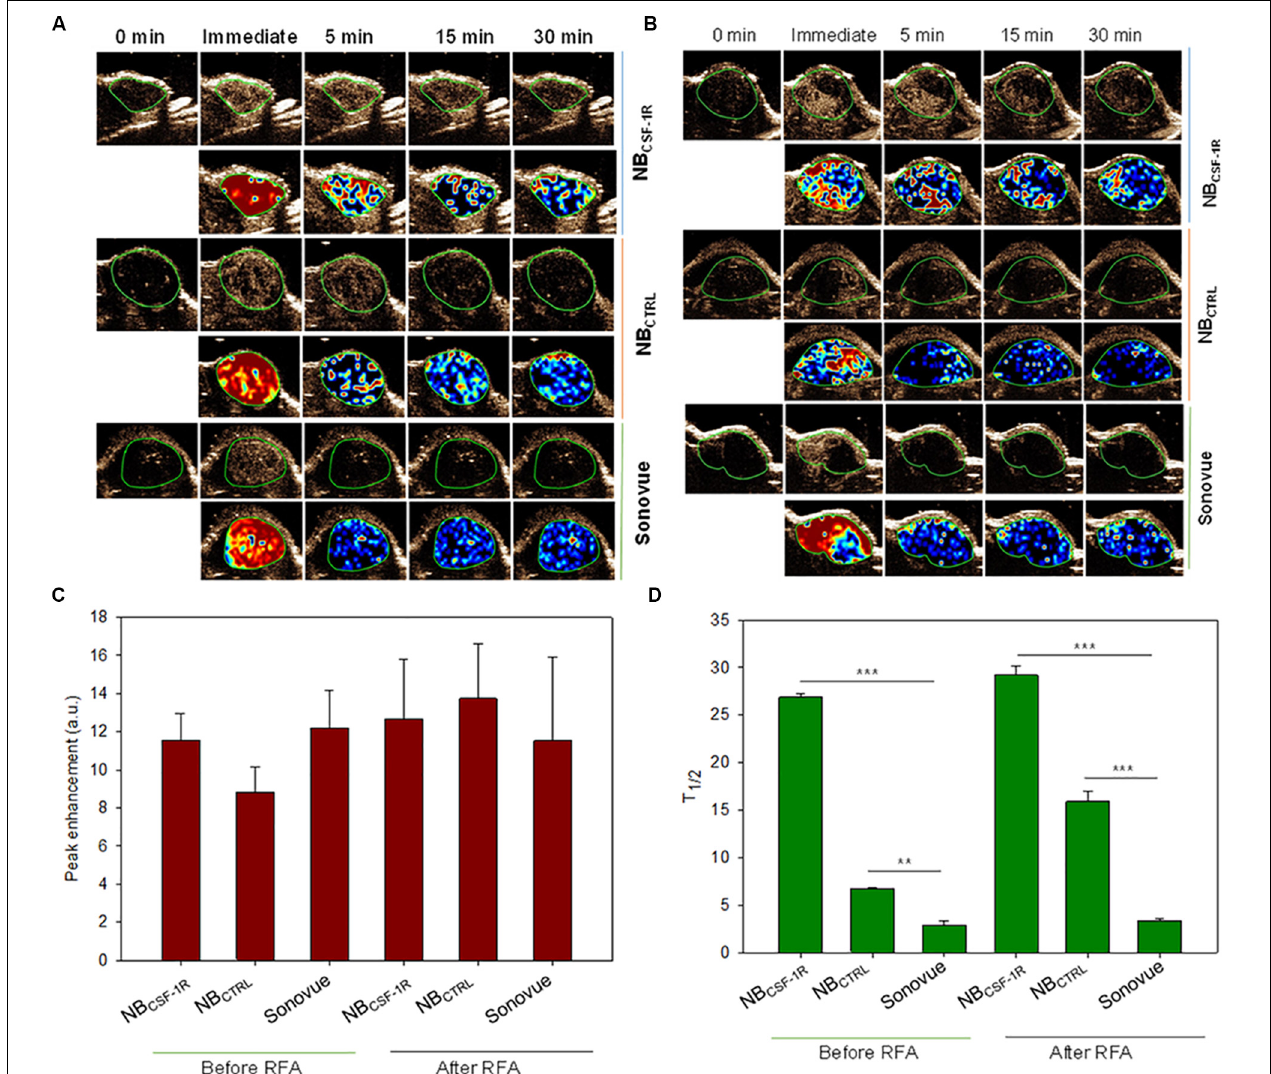
FIGURE 7 | (A) In vivo tumor imaging, images were taken at the indicated time points (0, immediate, 5, 15, and 30 min) after NB CSF − 1R , NB CTRL , and Sonovue R (cid:13) were injected into tail vein of the transplanted tumors. (B) In vivo tumor imaging, images were taken at the indicated time points (0, immediate, 5, 15, and 30 min) after NB CSF − 1R , NB CTRL , and Sonovue R (cid:13) were injected into tail vein of insufficient radiofrequency ablation (IRFA) models. Perfusion imaging was also taken to show the nanobubble diffusion. (C) The peak intensity of NB CS − F1R , NB CTRL , and Sonovue R (cid:13) was showed and there was no significant difference in each group. (D) The washout half-time in six group was show, and the NB CSF − 1R can provide longer imaging time in the xenograft tumor and IRFA models (**indicates p < 0.05, ***indicates p <